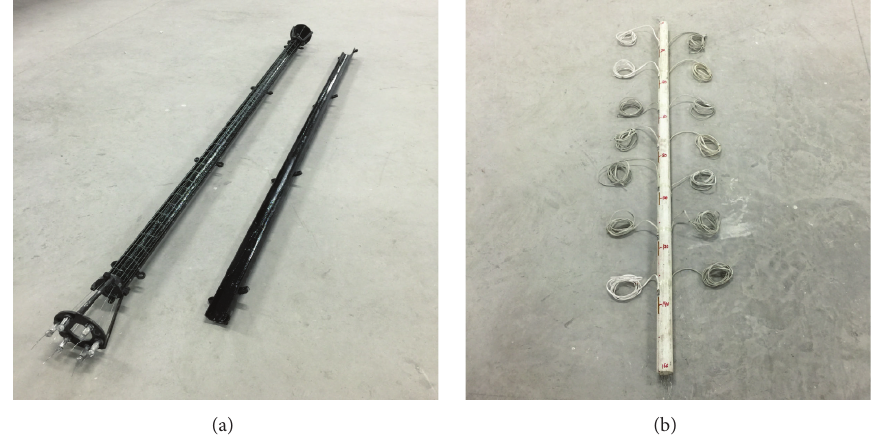
Figure 2: (a) The model pile template and (b) the model piles.